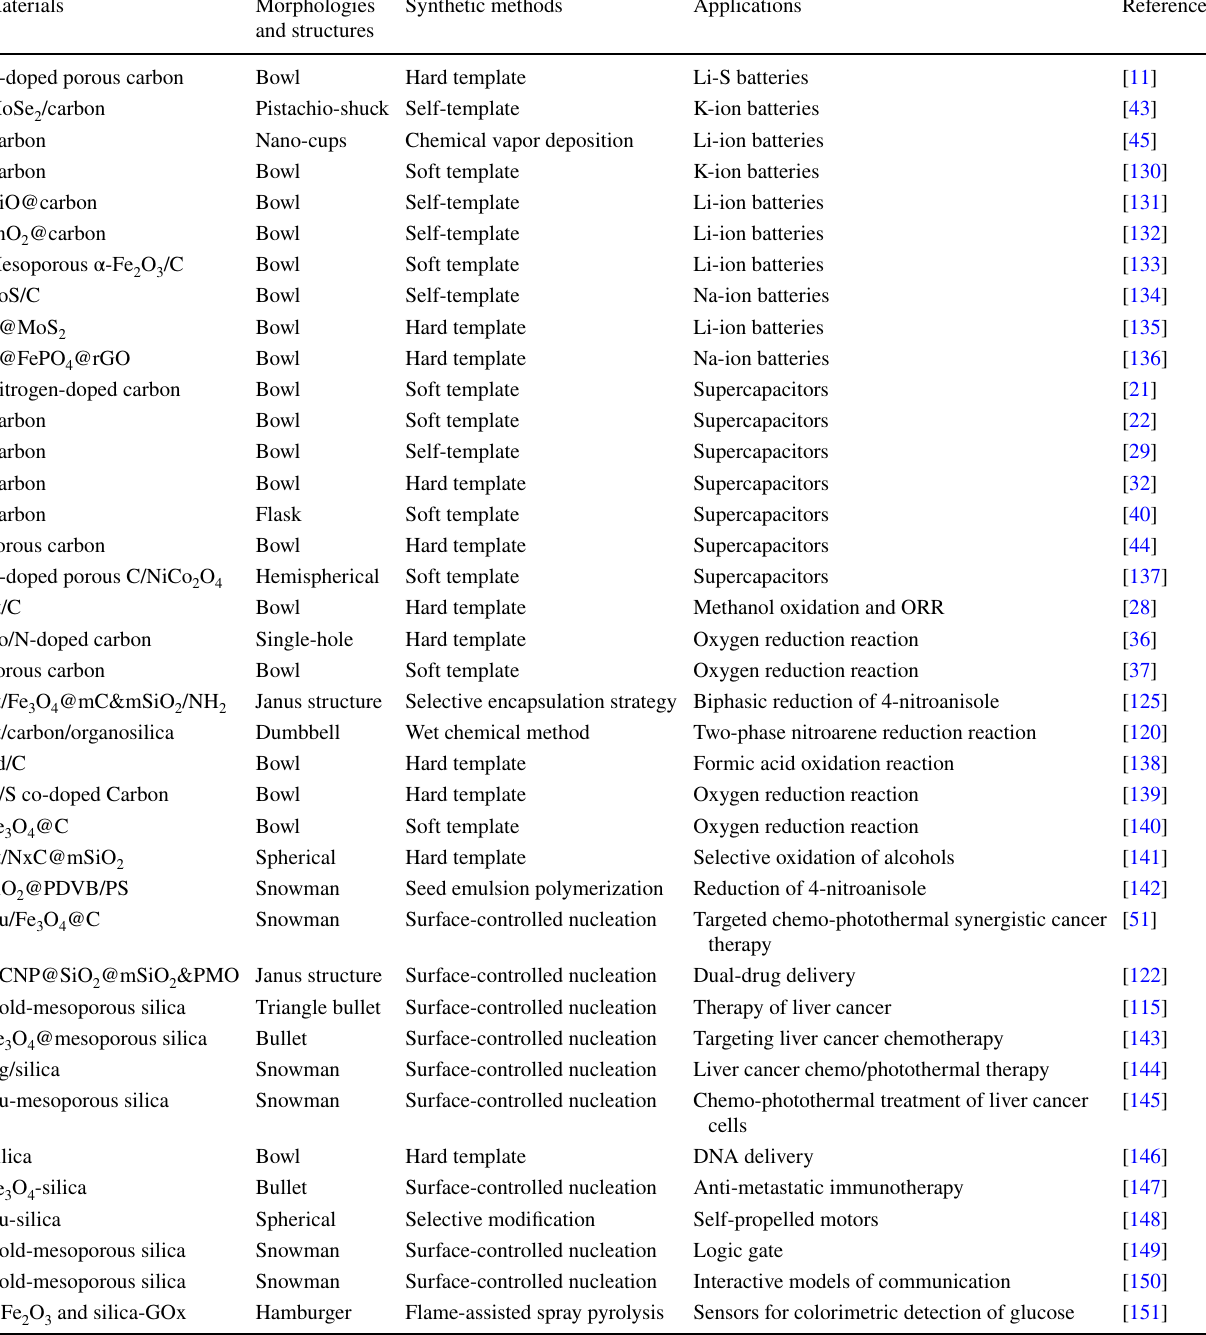
Table 1 A summary of synthetic methods, morphology and structure, and their different applications of asymmetric carbon- and silica-based